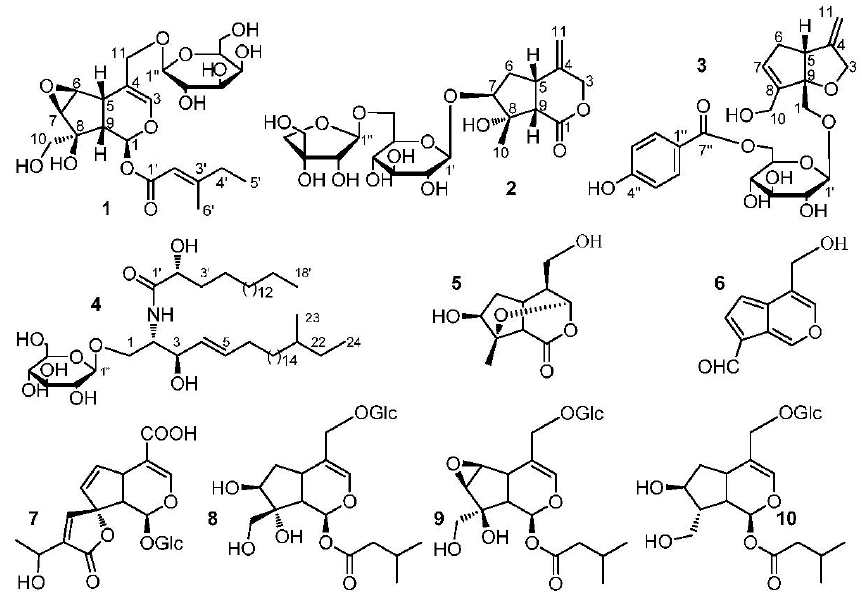
Figure 2. The structures of compounds 1 – 10 .